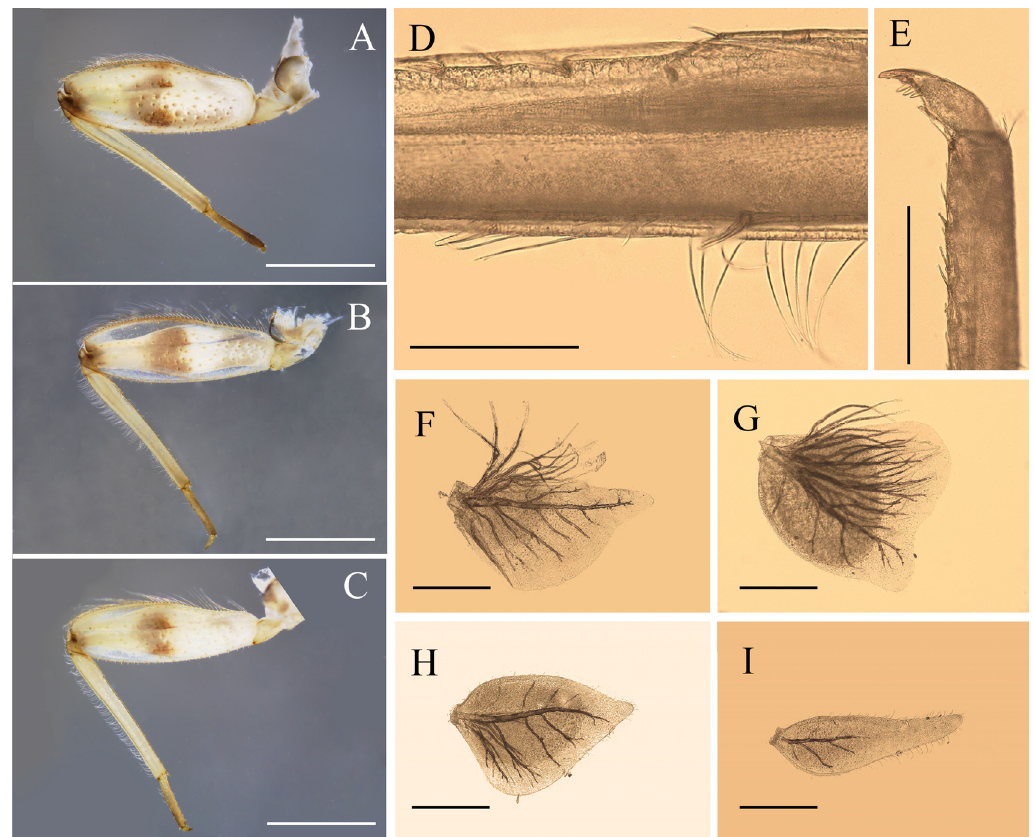
Figure 4. Nymphal structures of Regulaneuria cingulata : ( A ) Foreleg; ( B ) Midleg; ( C ) Hindleg; ( D ) Hindleg tibia; ( E ) Foreleg claw; ( F ) Gill I; ( G ) Gill II; ( H ) Gill VI; ( I ) Gill VII. Scale bars: ( A – C ) = 1.0 mm; ( D ) = 0.2 mm; ( E ) = 0.5 mm; ( F – I ) = 0.2 mm.